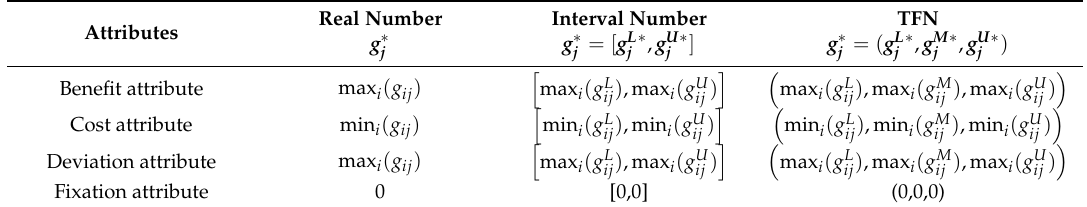
Table 1. Determination of positive ideal solutions (PISs) for heterogeneous attributes in different mathematical descriptions. TFN: triangular fuzzy number.